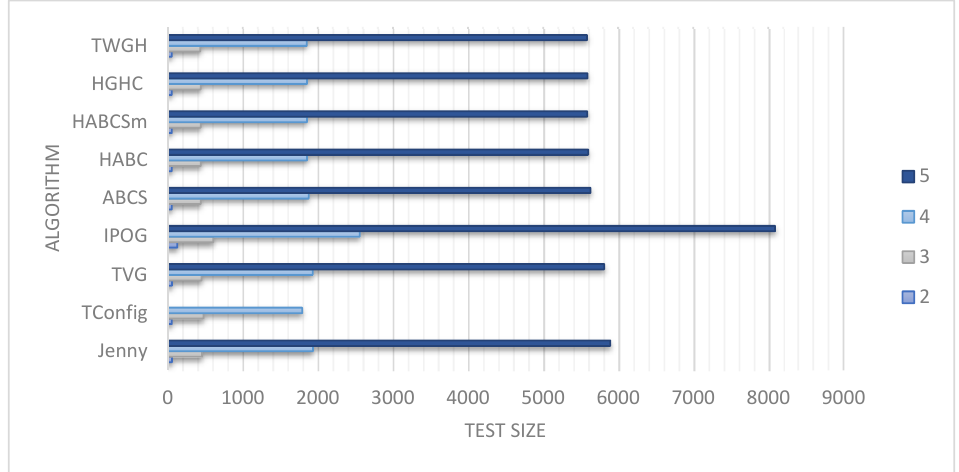
Figure 4. Test set size for CA (N; t, v 7 ) with t = 4 and 2 ≤ v ≤ 5.